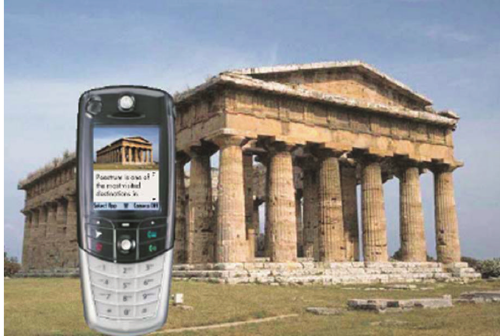
Figure 1: The Agamemnon project.